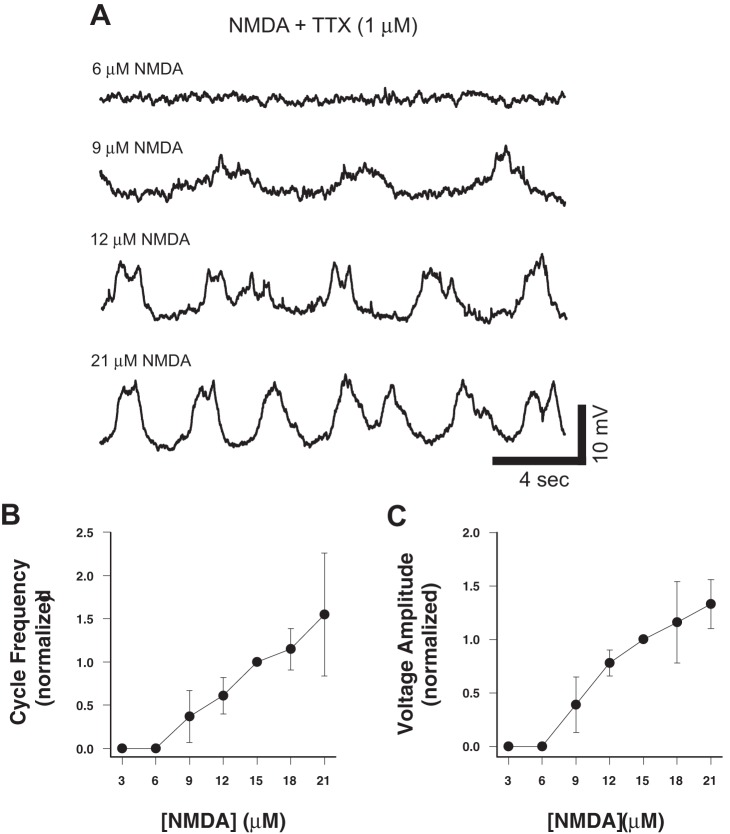
Concentration dependence of NMDA-induced membrane potential oscillations in Hb9 interneurons. A,Whole-cell current-clamp recordings of membrane potential from a single Hb9 interneuron at several NMDA concentrations. Note the lowest NMDA concentration (6 μM) does not induce oscillations. B–C, NMDA dose-response curves for cycle frequency show a linear relation above 6 μM (r = 0.87, p<0.001, n = 20) and voltage amplitude (r = 0.92, p<0.001, n = 20). The threshold for oscillation activation is ∼9 μM. Data are normalized to 15 μM.